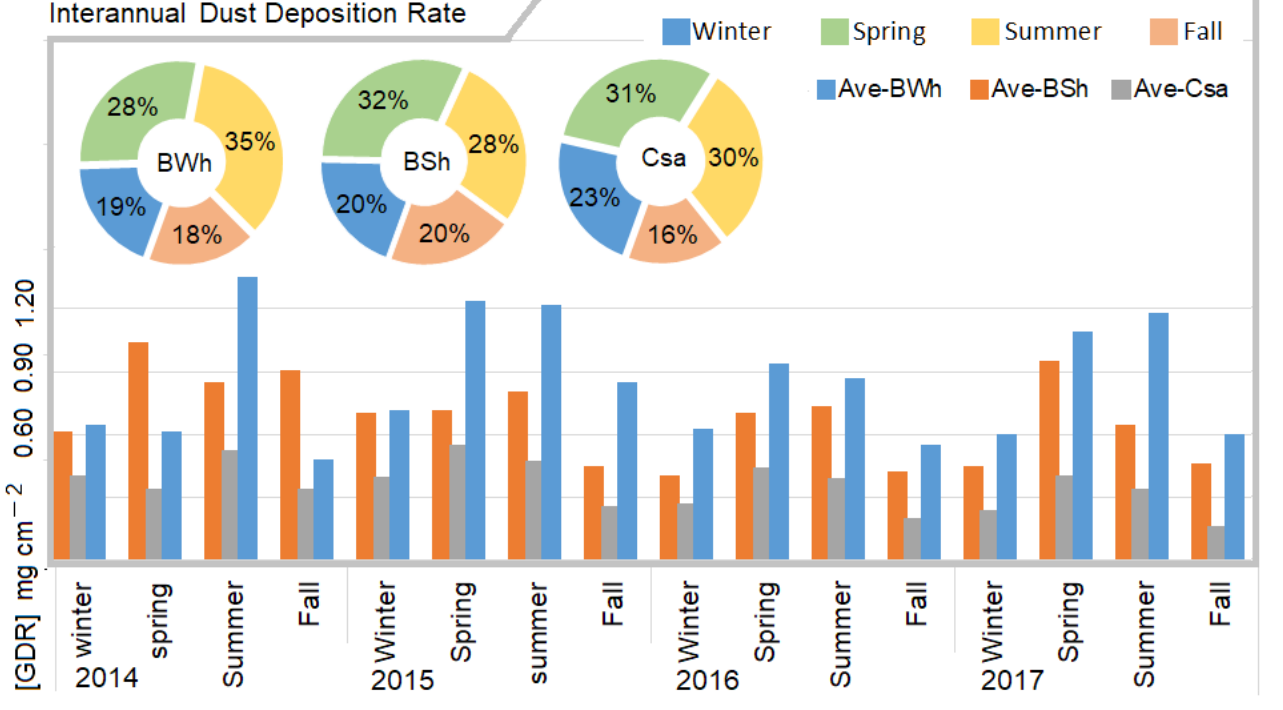
Figure 10. Overall seasonal deposition rates (mg cm − 2 ) in the study area. Spain [70], observations showed unusually high winter deposition